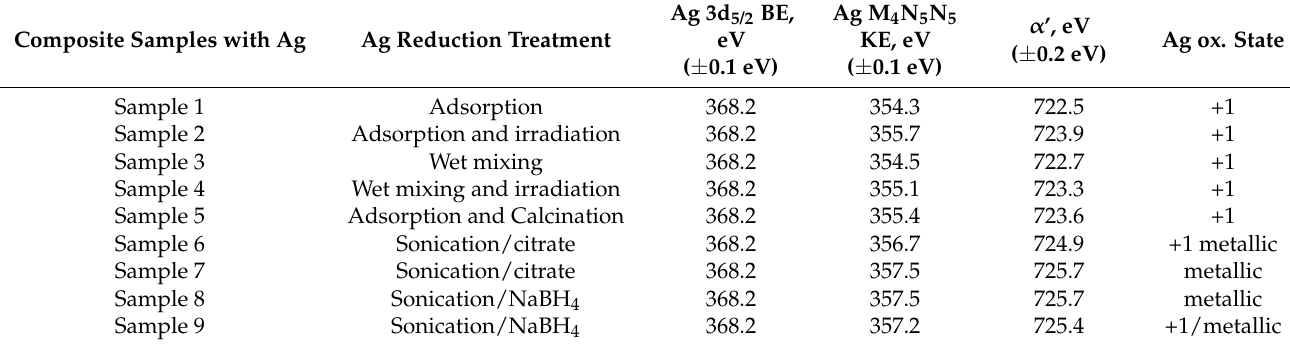
Table 3. Values of Ag 3d 5/2 BE, Ag M 4 N 5 N 5 KE, Auger parameter α ’ and Ag oxidation state for all the composite samples before and after reduction